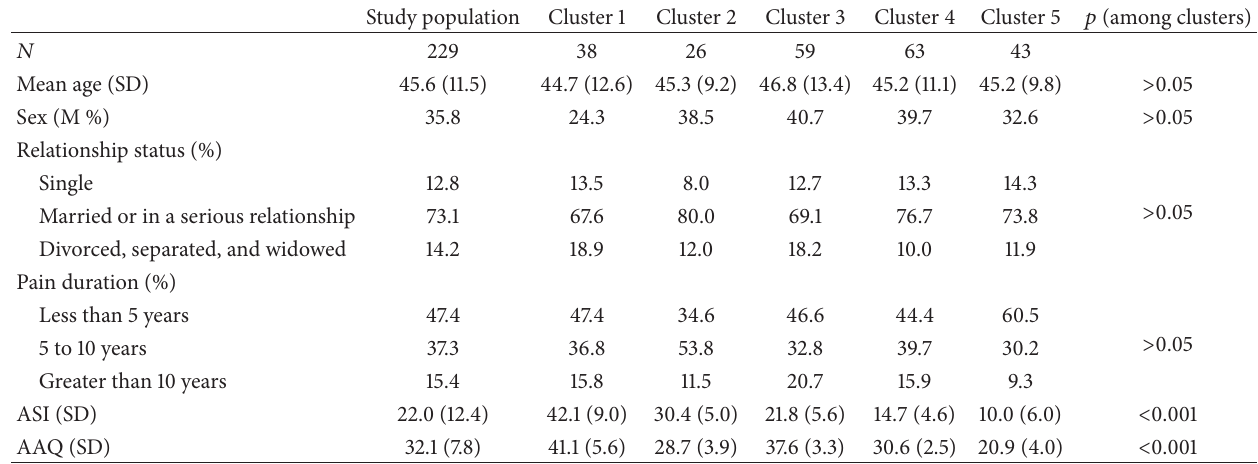
Table 2: Demographic and clinical characteristics of study population and participants subdivided into the five-cluster